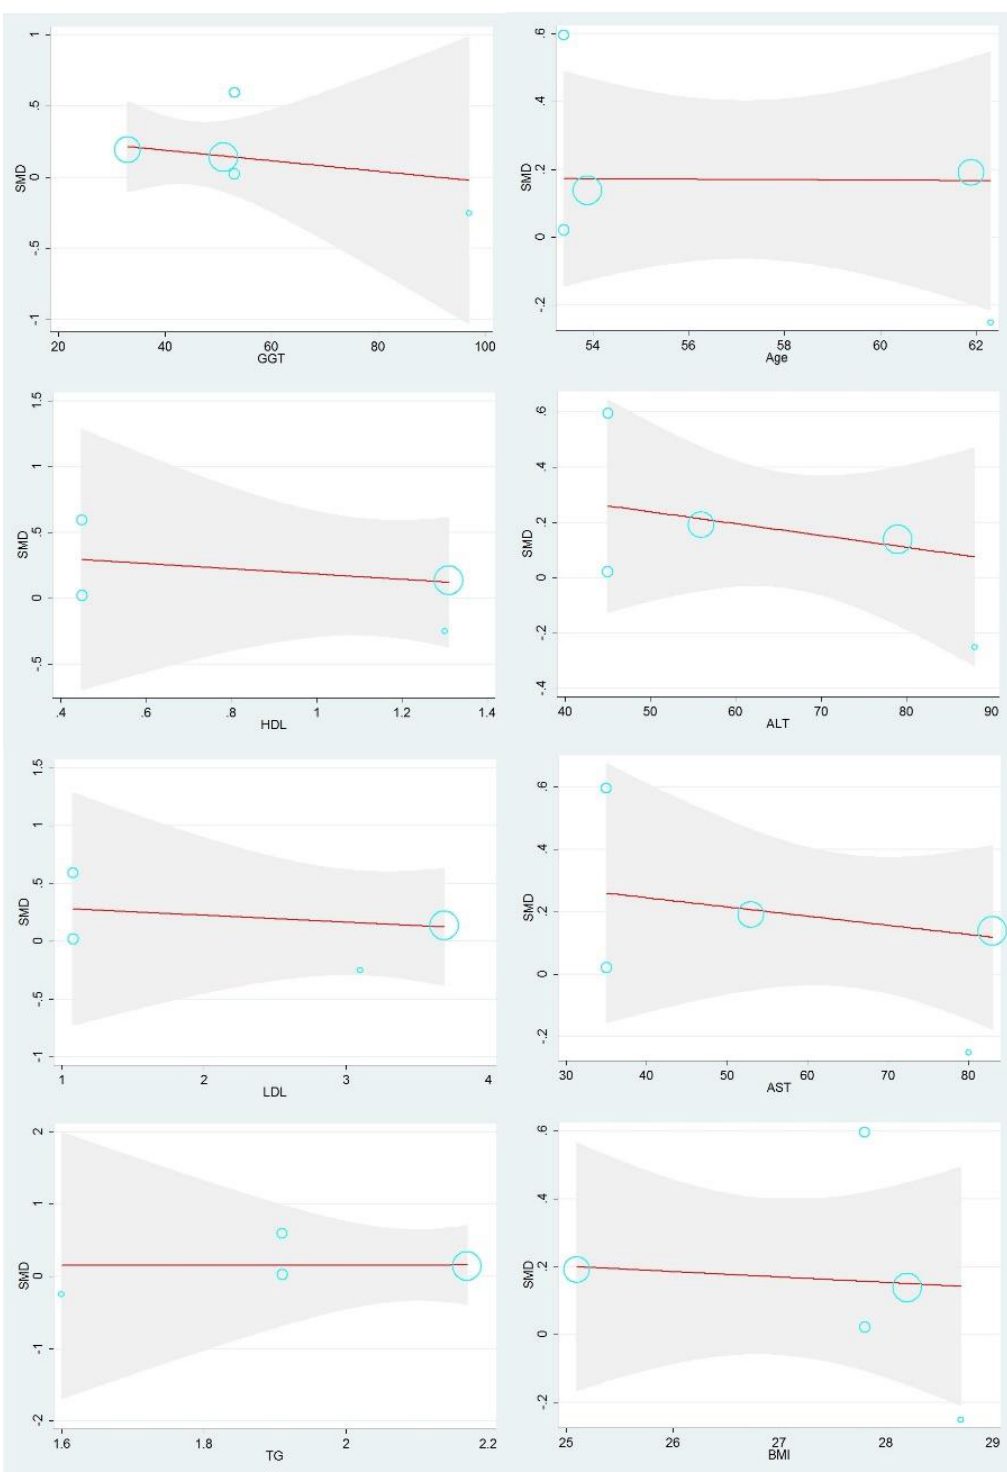
Figure 4. Dose-response relationships between clinical parameters of fetuin-B and SMD value outcomes based on data from each study. Each data point overlaps into a circle. The size of a circle represents the weight of the corresponding data point, and the larger the circle, the greater the impact. NAFLD, non-alcoholic fatty liver disease; AST, aspartate aminotransferase; ALT, alanine aminotransferase; GGT, glutamyl transpeptidase; LDL, low-density lipoprotein; HDL, high-density lipoprotein; TG, triglycerides; BMI, Body Mass Index; SMD, standardized mean difference.